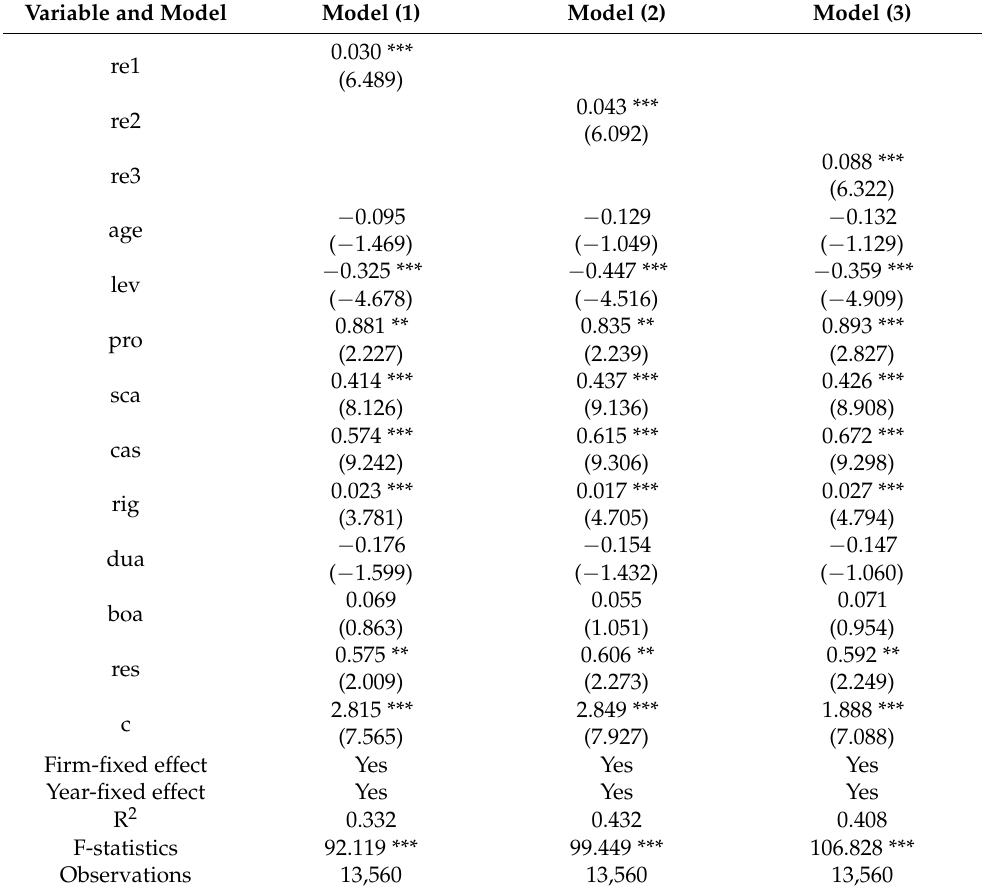
Table 3. Results of the effect of religious community on corporate social